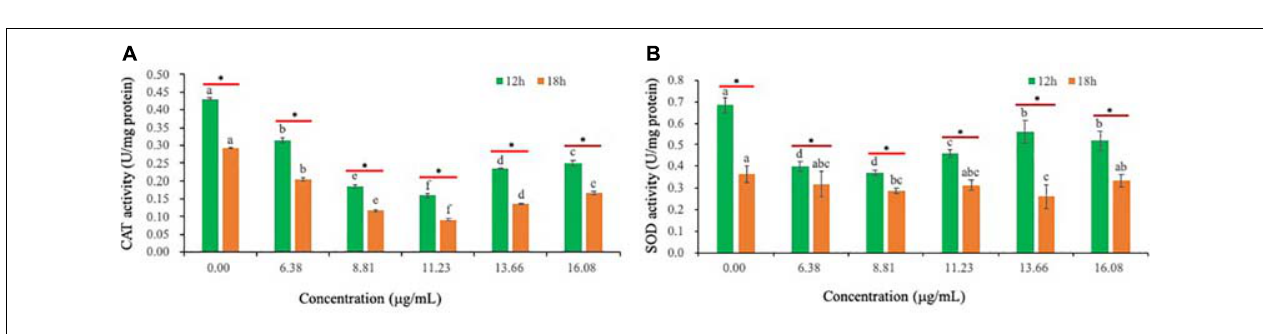
FIGURE 8 | The activities of catalase (CAT) and superoxide dismutase (SOD) of Ps. camelliae-sinensis strain GZHS-2017-010 hyphae treated with phenazine-1-carboxylic acid (PCA). (A) Effects on CAT activity. Any two samples with shared lowercase letters showed no significant differences, P > 0.05; (B) Effects of SOD activity. Any two samples with shared lowercase letters showed no significant differences, P > 0.05.